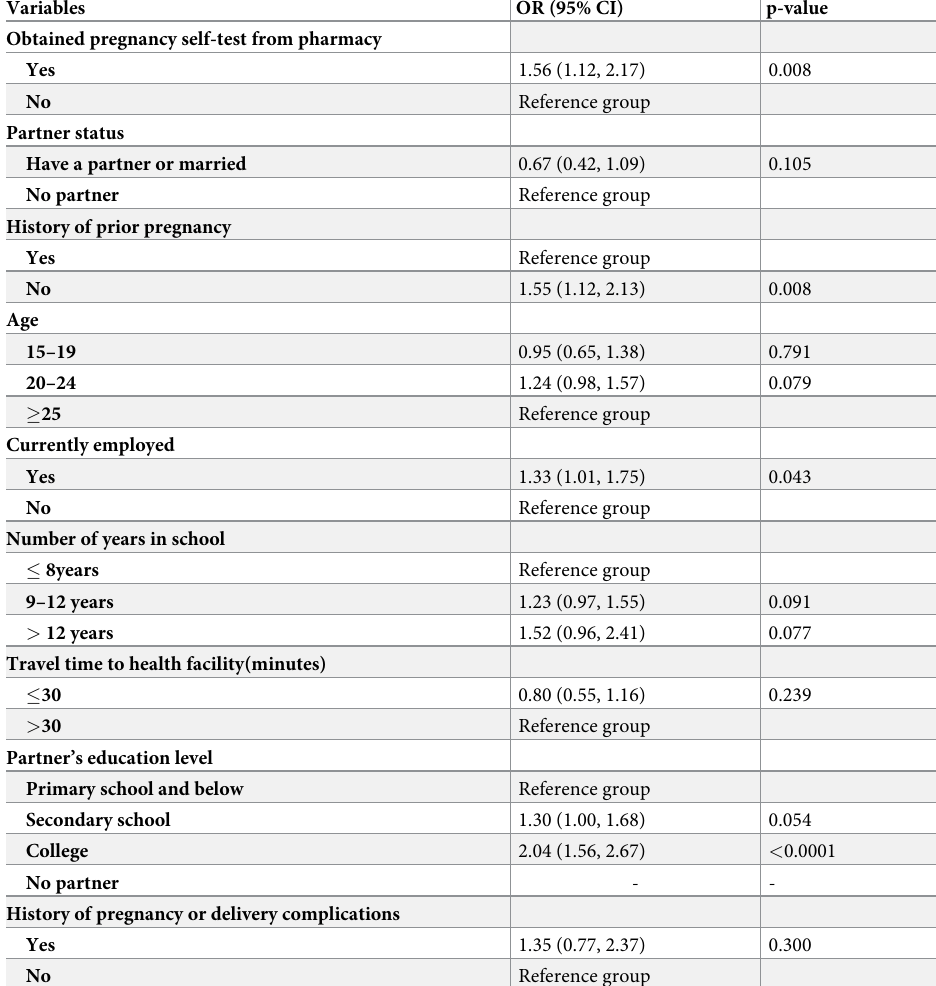
Table 3. Univariate logistic regression examining the variables associated with early ANC initiation.